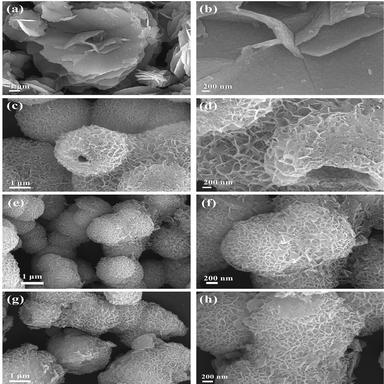
SEM images of NiO (a, b), NiMoO4 (c, d), NiO@NiMoO4 (e, f) and NiO@NiMoO4@PPy (g, h).